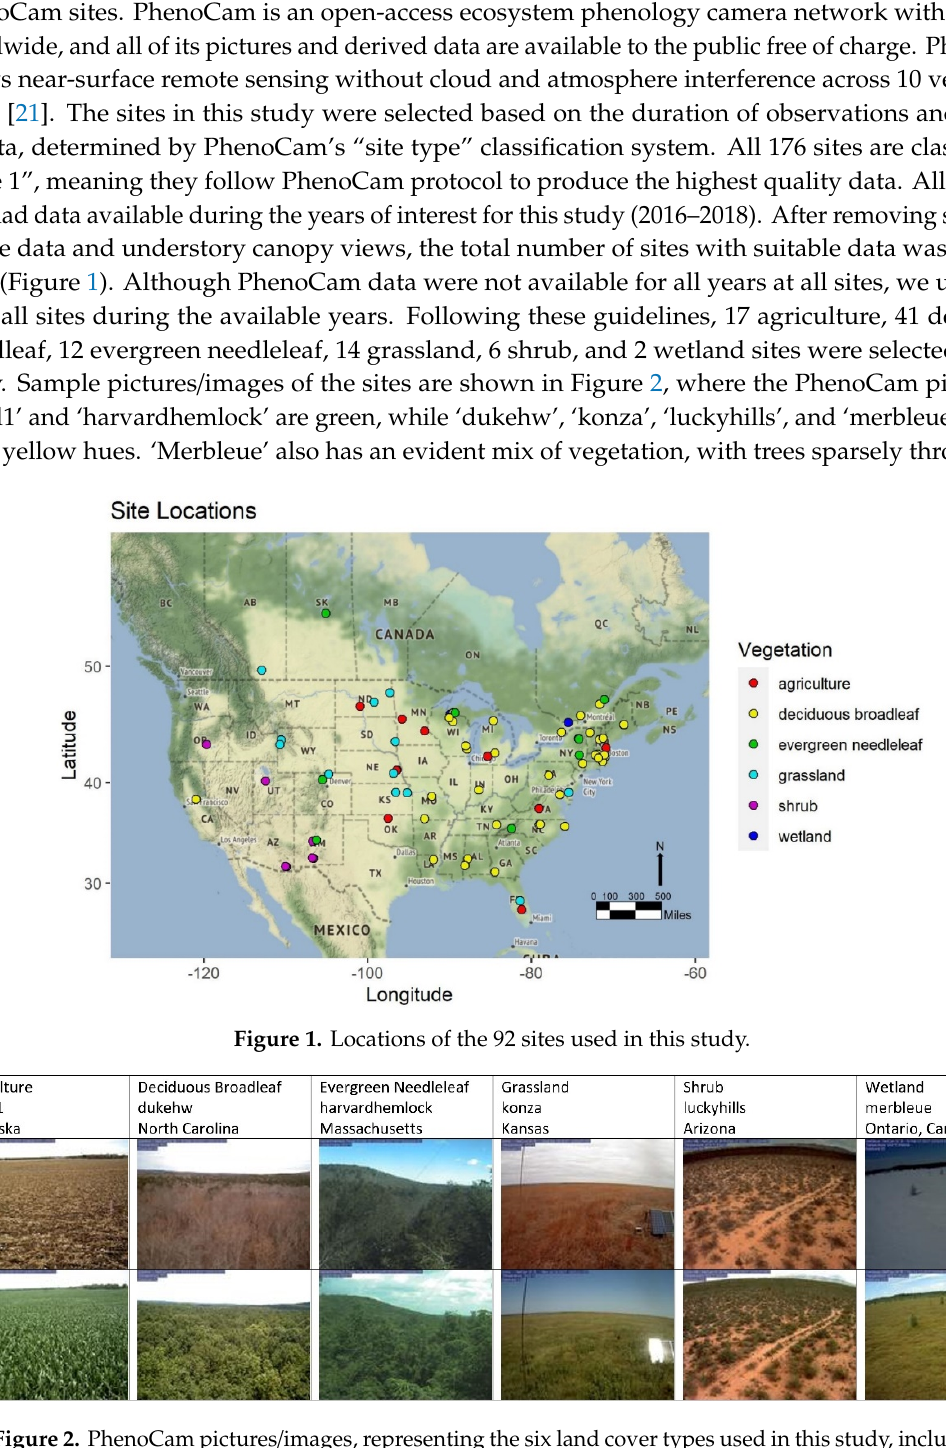
Figure 2. PhenoCam pictures/images, representing the six land cover types used in this study, including site name and general location. The first row of pictures is for February 2017, and the second row is for July 2017. Pictures/images were obtained from the PhenoCam online gallery [21].